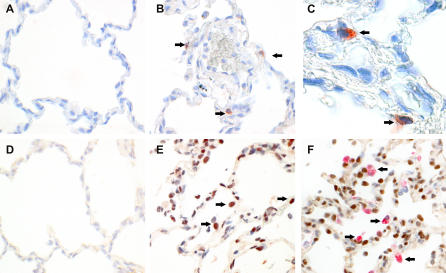
Detection of IFN-β and Phosphorylated STAT1 in Lung of SARS-CoV–Infected Macaques Using Immunohistochemistry(A) Lack of IFN-β expression in lungs of mock-infected macaques (magnification 40×) and (B, C) expression of IFN-β (red) in lungs of SARS-CoV–infected macaques at day 1 post infection (40× [B] and 100× [C], arrowheads). (D) Lack of phosphorylated STAT1 in lungs of mock-infected macaques (40×) and (E) abundant presence of phosphorylated STAT1 (brown) in lungs of SARS-CoV–infected macaques at day 1 post infection (40×, arrowheads). (F) No detection of phosphorylated STAT1 (brown) in SARS-CoV–infected cells (red) (40×, arrowheads).